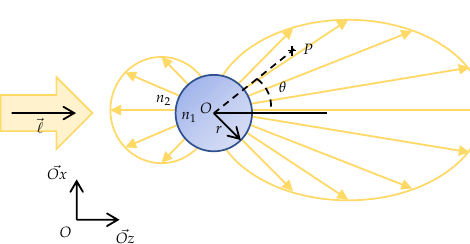
Figure 2. Geometric representation of the diffusion from a spherical particle. In yellow, a schematic representation of the Mie diffusion by a spherical